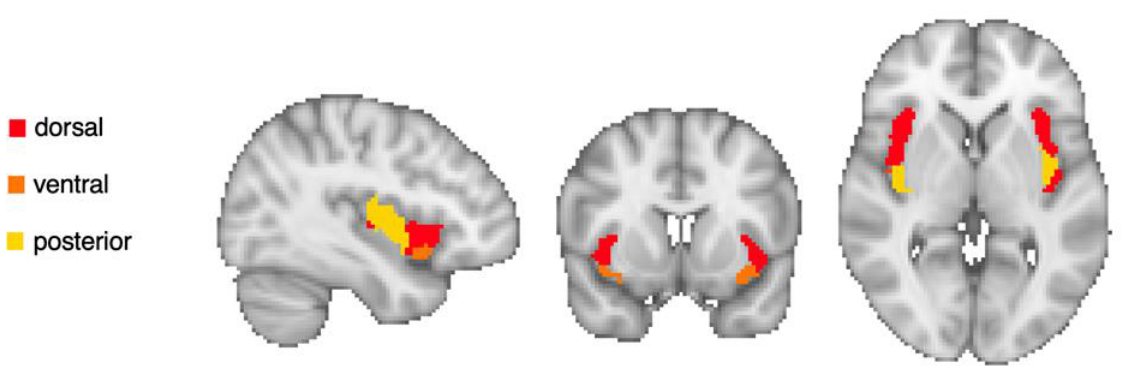
Figure 2. Region of interest (seeds) in bilateral dorsal (red), ventral anterior (orange) and posterior (yellow) insula.